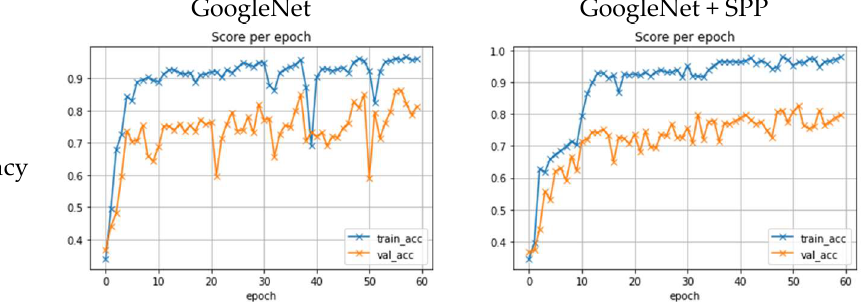
Figure 11. Performance comparison analysis between GoogleNet and GoogleNet + SPP.